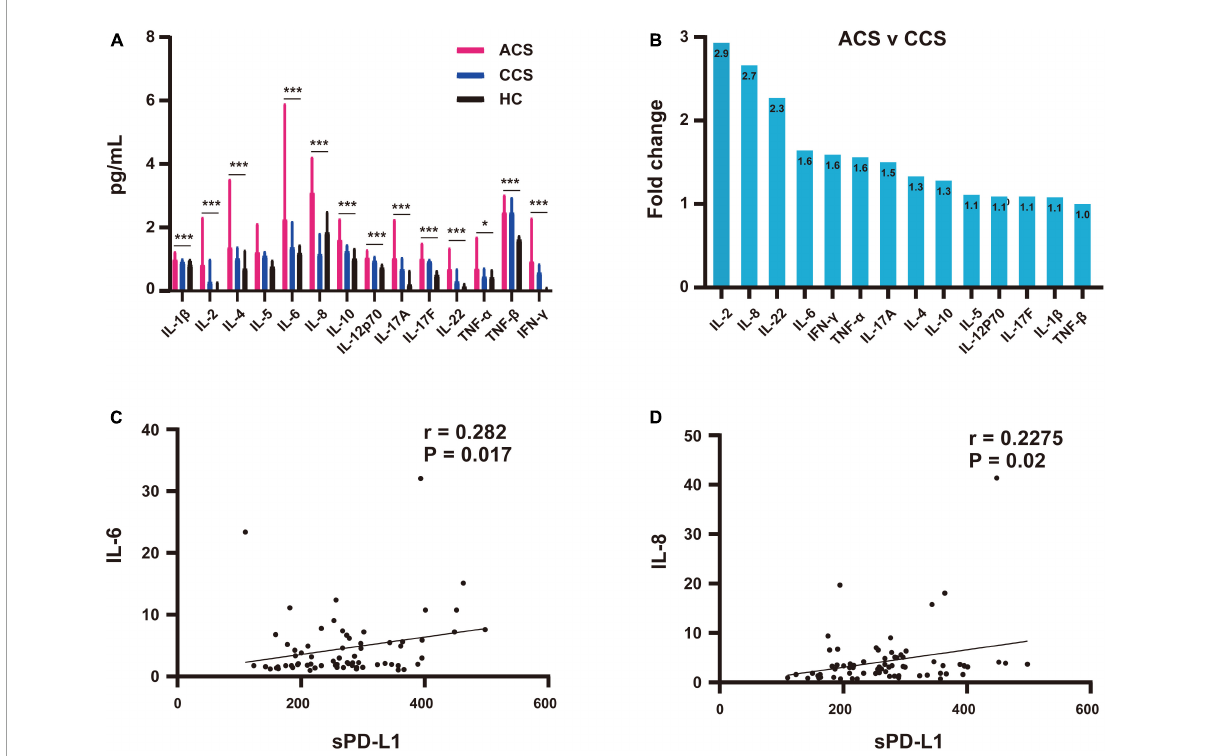
FIGURE4 Association of plasma sPD-L1 with elevated IL-6 and IL-8 levels in ACS patients. (A) Comparison of elevated fold changes in inflammatory cytokine levels among the ACS ( n = 71), CCS ( n = 17) and HC ( n = 47) groups. (B) Increased inflammatory cytokine concentrations in the ACS group compared with the CCS group. (C) Association of sPD-L1 with IL-6 in the ACS ( n = 71) group. (D) Association of sPD-L1 with IL-8 in the ACS ( n = 71) group. * p < 0.05; *** p <